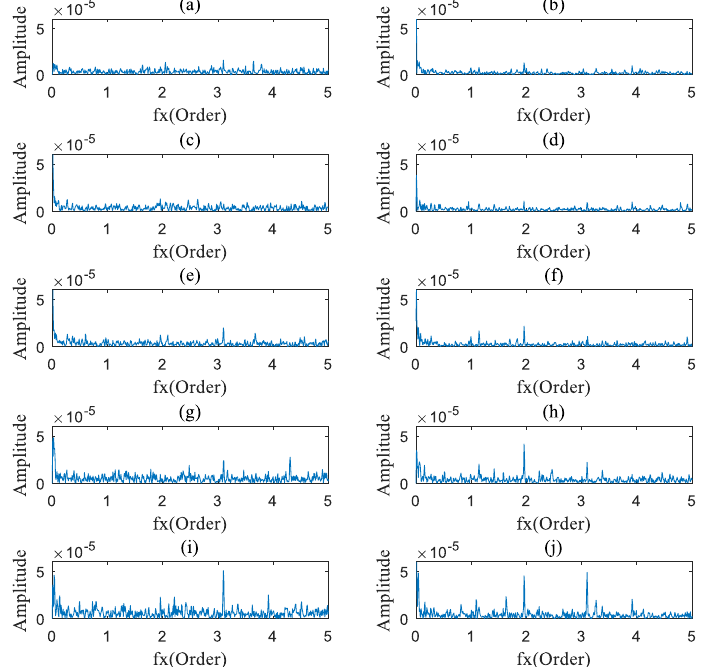
Figure 10. The characteristic slice under 20% rated speed conditions: ( a ) Healthy PG at 0% rated load; ( b ) Pitting fault on sun gear of PG at 0% rated load; ( c ) Healthy PG at 25% rated load; ( d ) Pitting fault on sun gear of PG at 25% rated load; ( e ) Healthy PG at 50% rated load; ( f ) Pitting fault on sun gear of PG at 50% rated load; ( g ) Healthy PG at 75% rated load; ( h ) Pitting fault on sun gear of PG at 75% rated load; ( i ) Healthy PG at 90% rated load; ( j ) Pitting fault on sun gear of PG at 90% rated